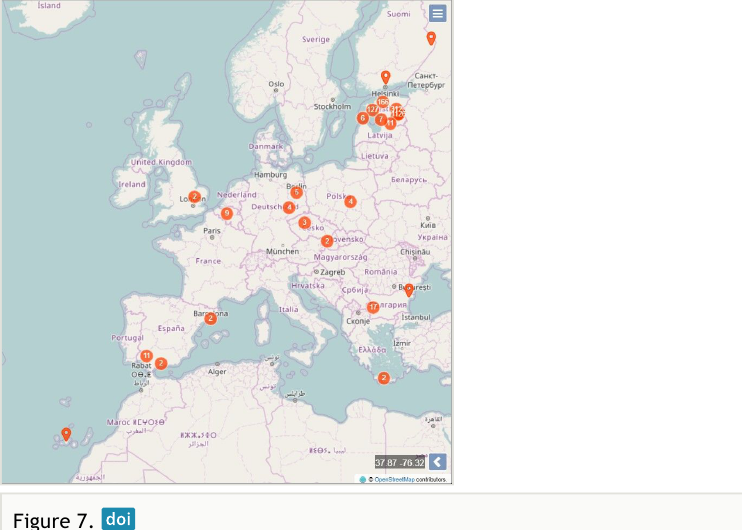
The occurrence map of "My naturesound" observations (as of August